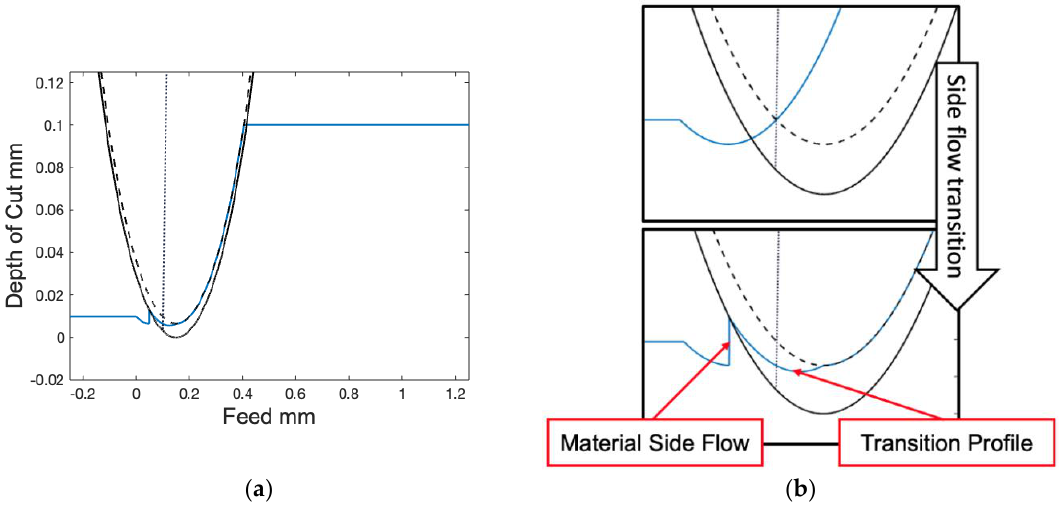
Figure 6. ( a ) Tool geometry imposed on new surface profile, altered by the current tool path segment; ( b ) magnified examples of the model geometry that clarify the side flow transition and surface profile construction.